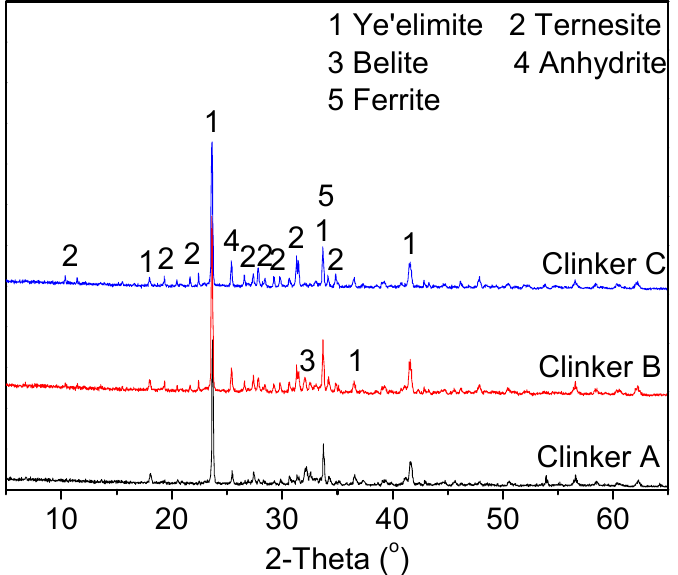
Figure 3. XRD patterns of cement clinkers produced with different amounts of gypsum in the raw mixes.